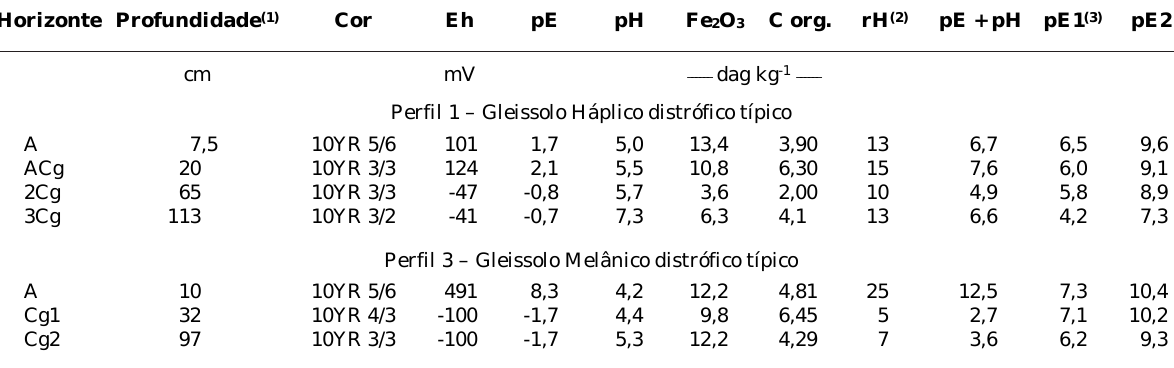
Horizonte Profundidade (1)